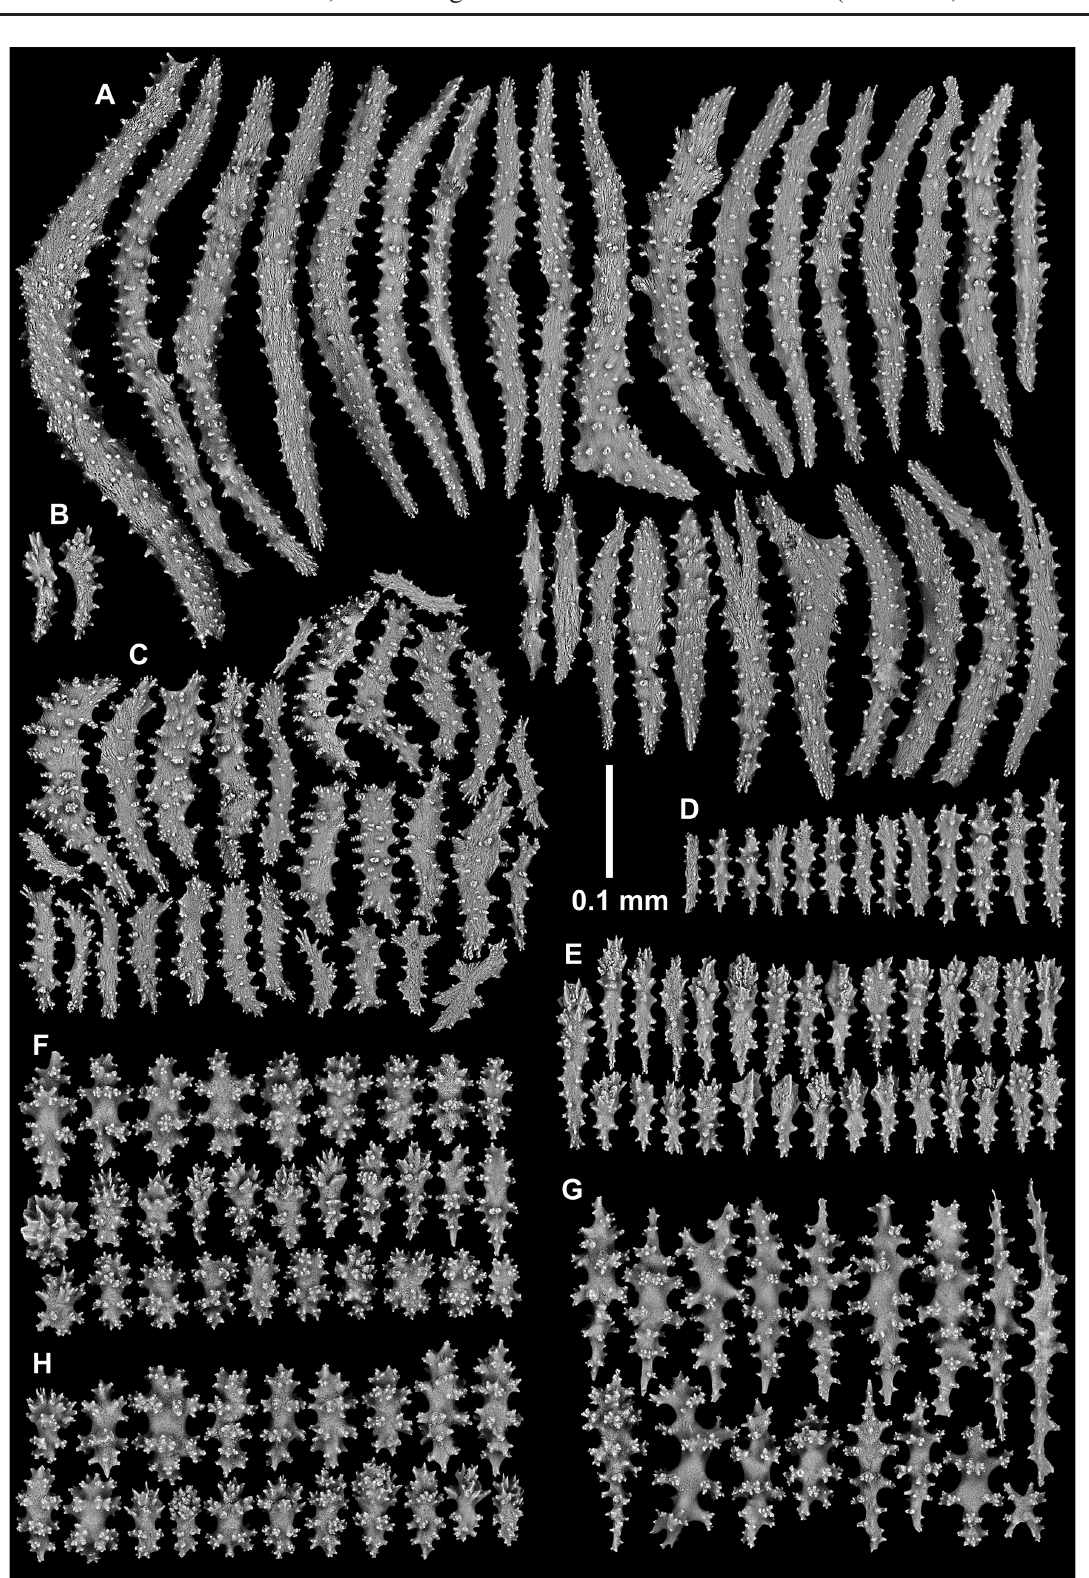
Fig. 9. Kotatea aurantiaca gen. et comb. nov. (NIWA 54766), SEMs of sclerites. A . Collaret and points. B . Distal points. C . Tentacles. D . Polyp neck. E . Polyp mound. F . Lobe surface. G . Lobe interior. H . Base